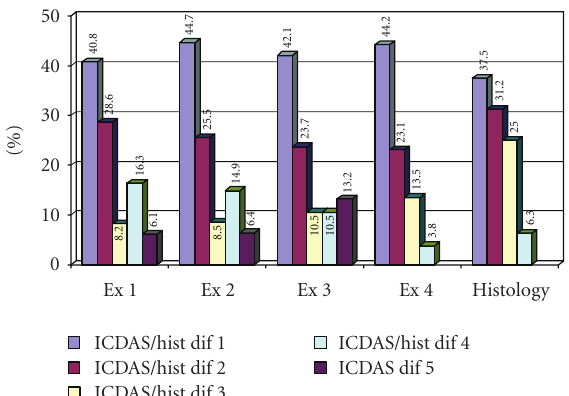
Figure 2: Frequency distribution (%) of the di ff erences between the scores in each surface for each examiner when using ICDAS-II and for the consensus histological